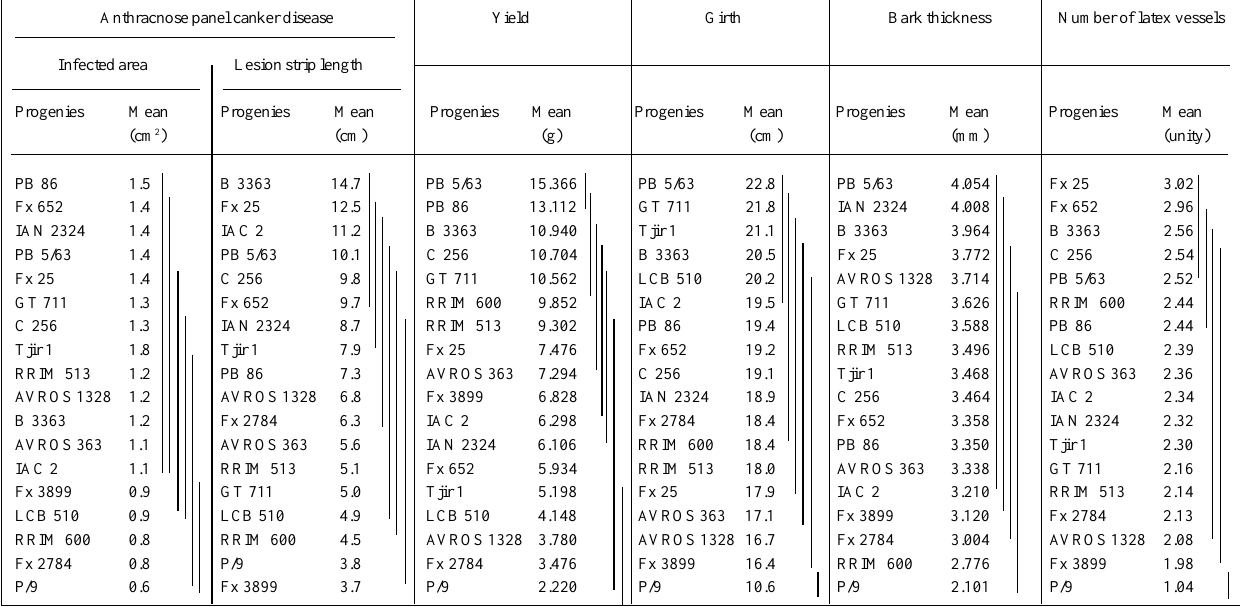
Table III - Distribution of rubber tree ( Hevea brasiliensis ) progenies into homogeneous groups for several characters according to Duncan’s test (P < 0.05). Anthracnose panel canker disease Yield Girth Bark thickness Number of latex vessels